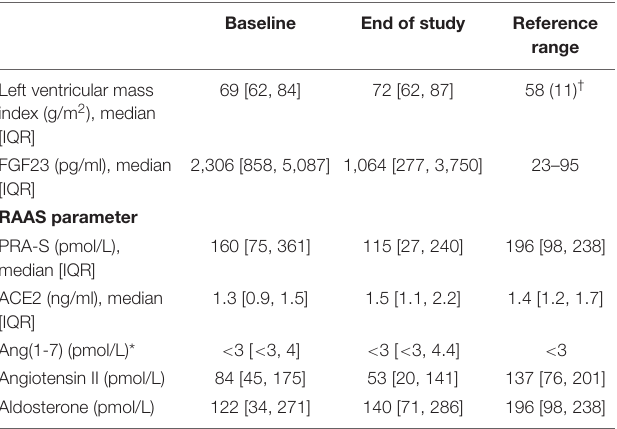
TABLE 2 | Measurement data at baseline and end of study (after 1 year of follow-up or last measurement available, in case a patient dropped out). Baseline End of study Reference range